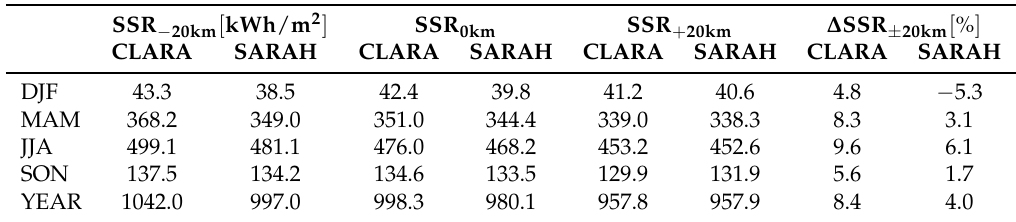
Figure 3. Climatological average (solid line) and standard deviation (colored shading) of the SSR for each season as a function of distance to the coastline for CLARA-A2 ( upper panel) and SARAH-2 ( lower panel). Ground-based pyranometer measurements of the SSR are shown as black filled circles with corresponding error bars denoting the standard deviation. See text for details. Table 2. Comparison of the climatological SSR at 20 km out on the sea, at the coastline, and 20 km inland according to CLARA-A2 and